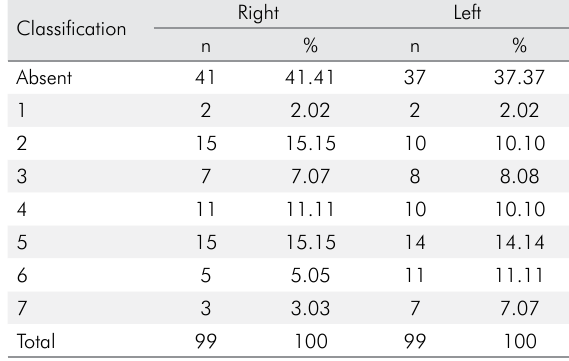
Figure 1. Axial CBCT showing the location of the CS behind the right canine (classification 6).